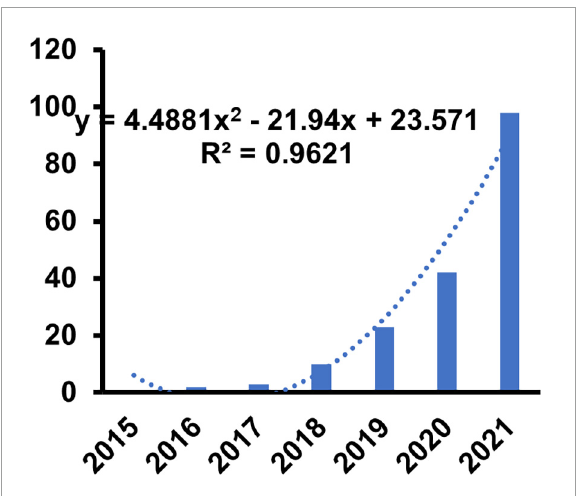
FIGURE1 Annual publication of the ferroptosis in cardiovascular disease.